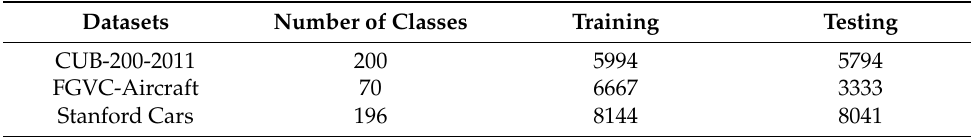
Table 1. Datasets in the